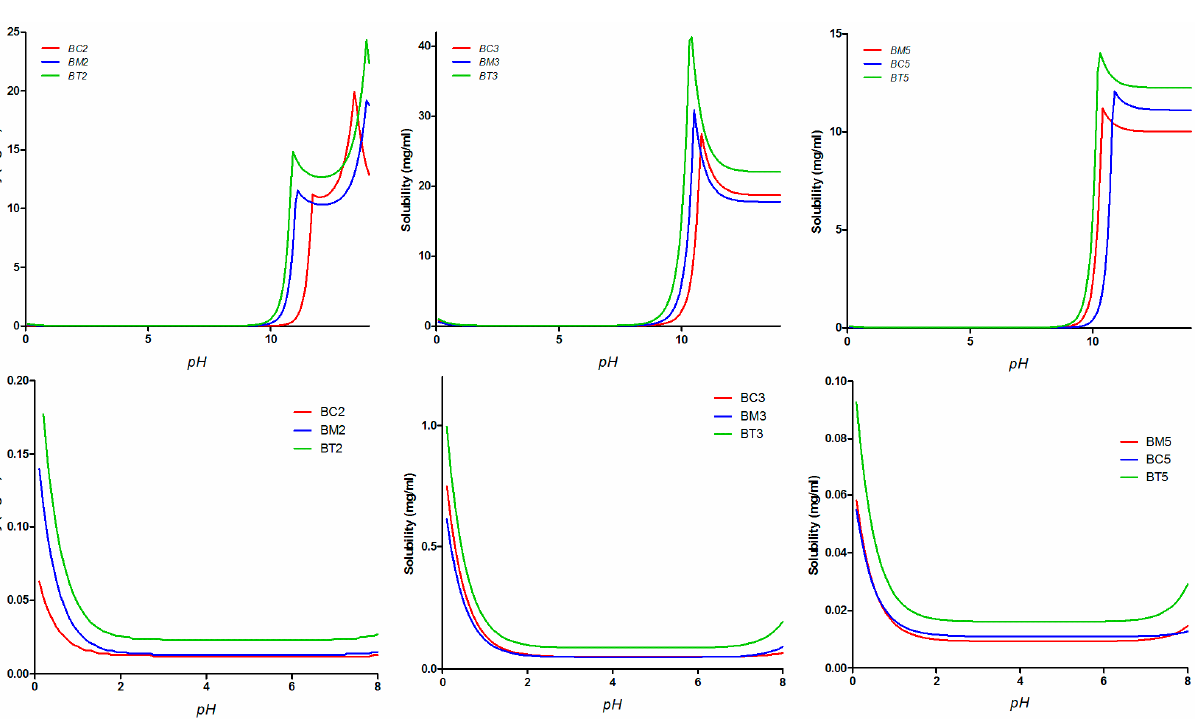
Figure 6. Simulated solubility vs. pH profiles for the tested compounds over the whole pH range ( top row) and only in the physiologically relevant range ( bottom